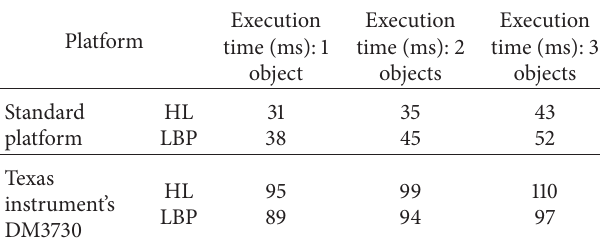
Table 1: Detection function parameters.